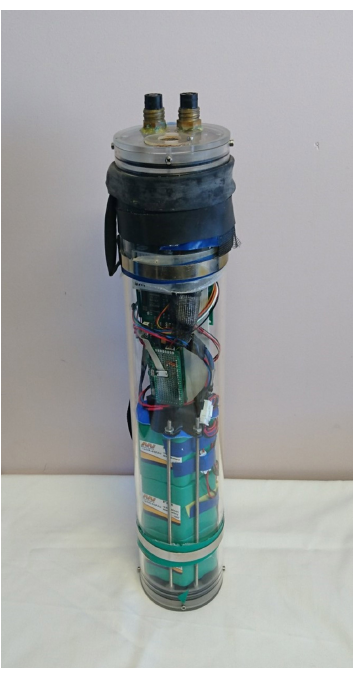
Figure 2. Submersible logging pH monitor. The fluorescence spot is located on the upper faceplate between and forward of the two submersible connectors, beneath a clear plastic